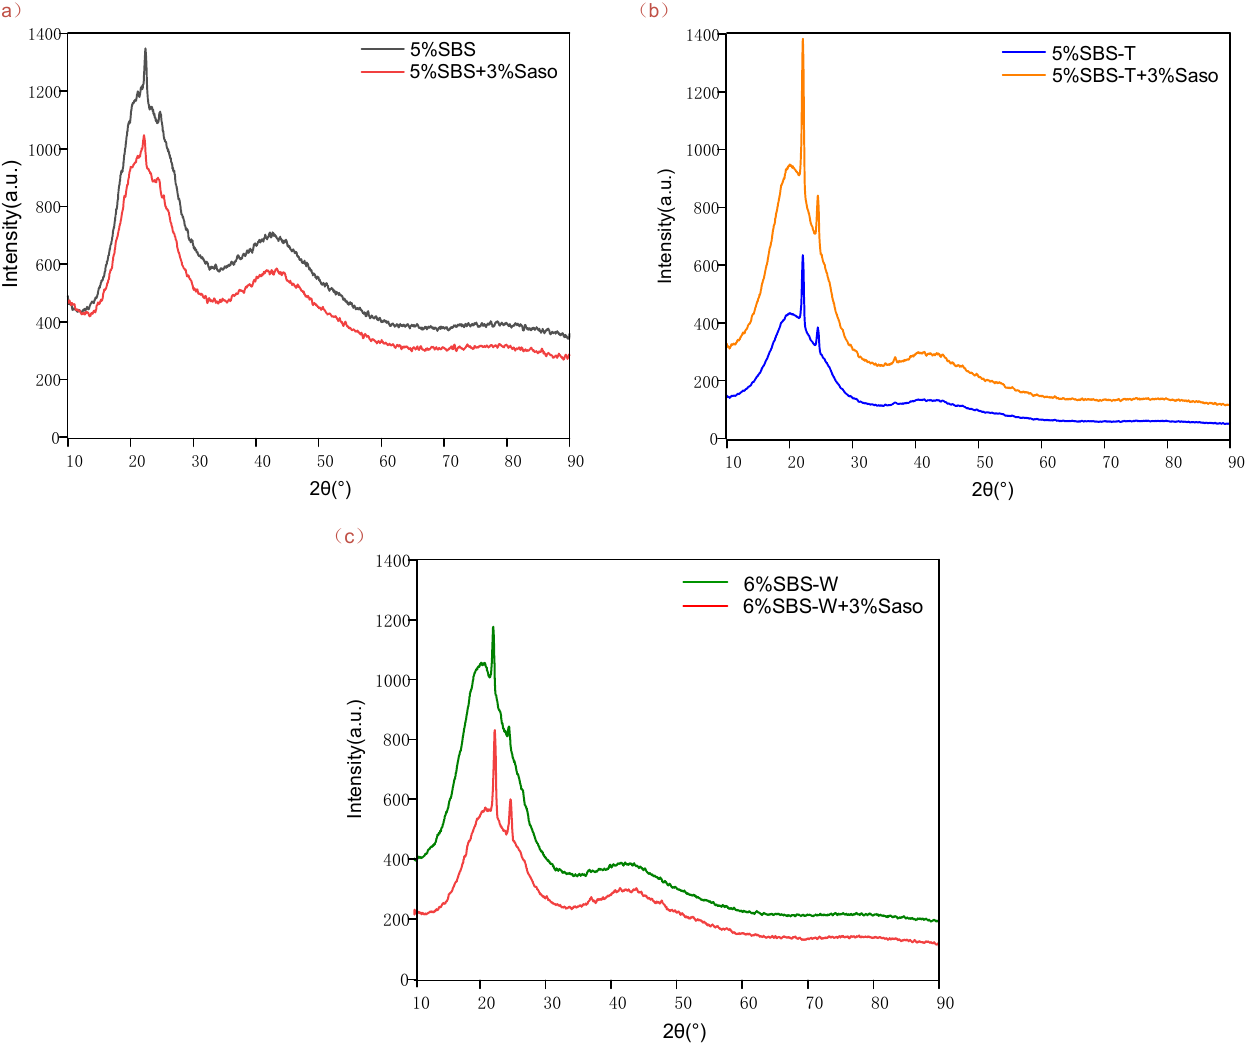
Figure 3. XRD pattern of modified asphalt. ( a ) SBS/Saso; ( b ) SBS ‐ T/Saso; ( c ) SBS ‐ W//Saso.